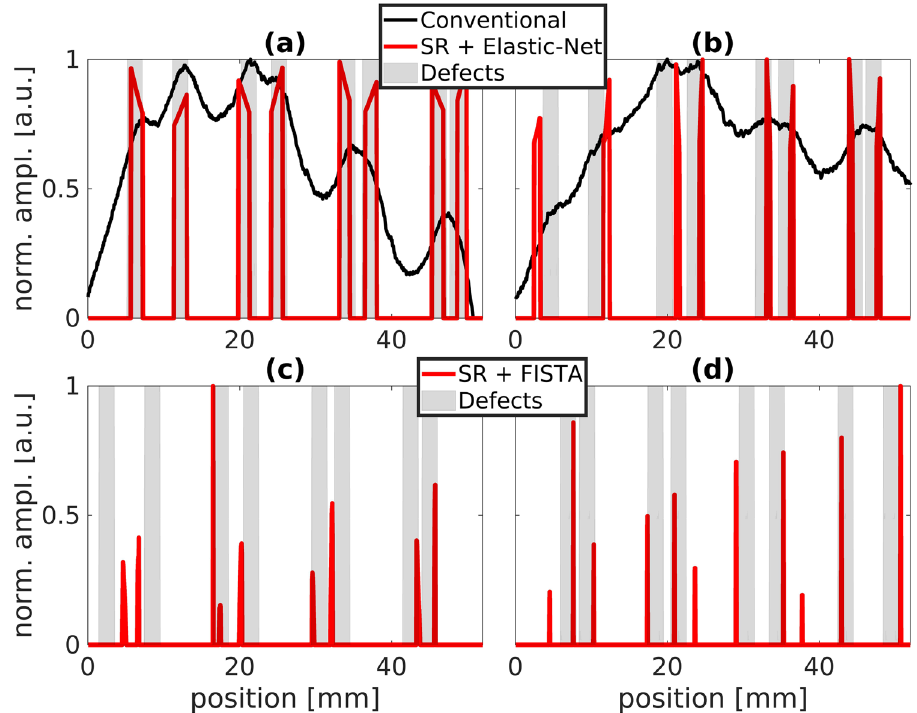
Figure 6. Normalized IJOSP results: ( a ) step scanning + refl.; ( b ) step scanning + trans.; ( c ) continuous scanning + refl.; ( d ) continuous scanning + trans. The diagrams in ( a , b ) show additionally the conventional result obtained by simply applying the maximum thermogram method to the raw data of a measurement where the whole sample surface is illuminated—here we illuminated the whole sample surface with a laser square 2 60 60mm 2 , t pulse = ×